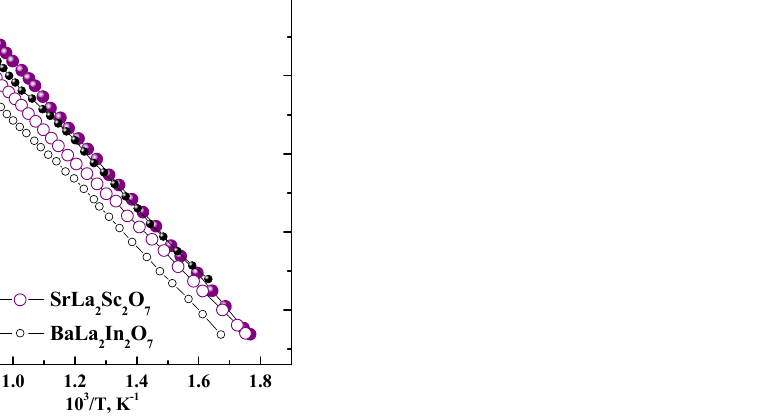
Figure 6. Temperature dependencies of conductivity for SrLa 2 Sc 2 O 7 and BaLa 2 In 2 O 7 compositions obtained under dry air (filled symbols) and dry Ar (open symbols) conditions.